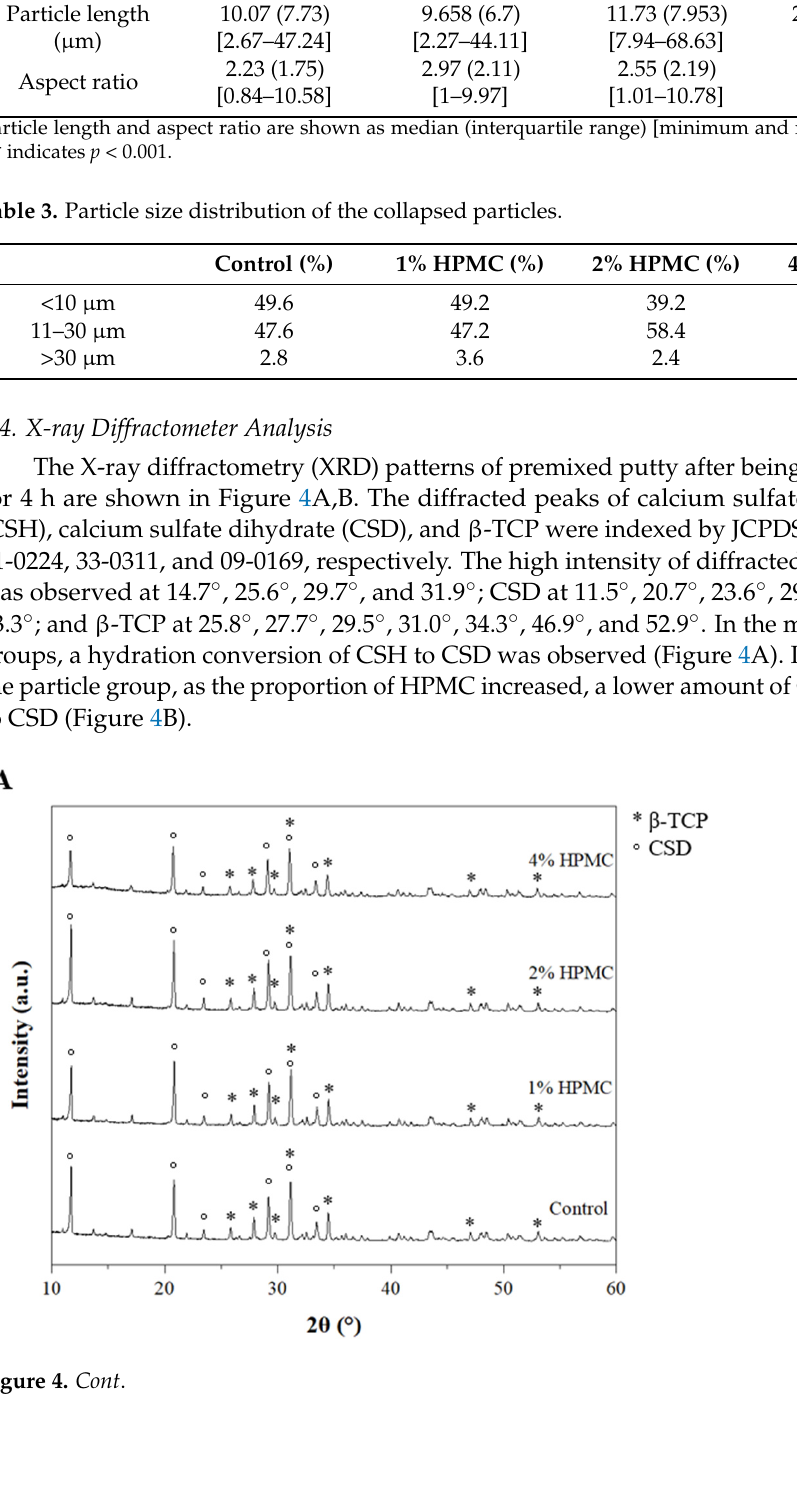
Figure 4. X-ray diffractometry patterns of premixed putty containing HPMC with different mass ratios after being soaked for 4 h (*: β -TCP; ◦ : calcium sulfate dihydrate (CSD), ▪ : CSH). ( A ) Patterns of the main body. ( B ) Patterns of particles. 4. Discussion Although CS-CP-based premixed putty has good biocompatibility, osteo-conduc- tion, and osteo-integration, the poor anti-washout ability limits the clinical utility of pre- mixed putty. HPMC and glycerin could increase the cohesion and maintain stability be- fore use [27,33] . Our results indicated the addition of HPMC could effectively improve the anti-washout properties of premixed putty; as HPMC increased, premixed putty was less washed out. The possible mechanism of HPMC action can be summarized into two as- pects. On the one hand, it has been shown that HPMC can provide 3D networking for materials such as mixing with collagen [23,40], and without HPMC the material structure was looser so it falls apart easily. It is possible that HPMC provided stronger structure for